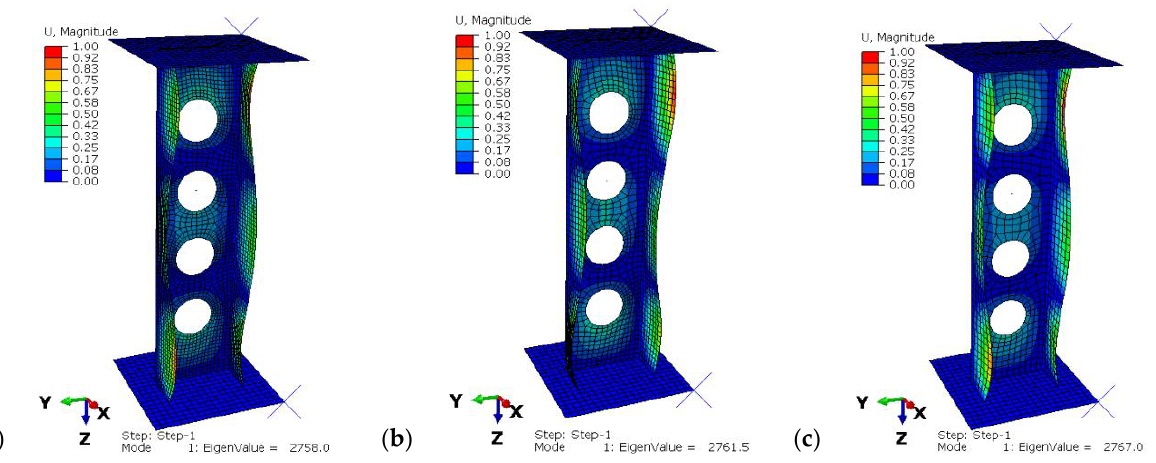
Figure 5. The results from convergence test: ( a ) mesh size = 3 mm, ( b ) mesh size = 4 mm, ( c ) mesh size = 5 mm. size = 5